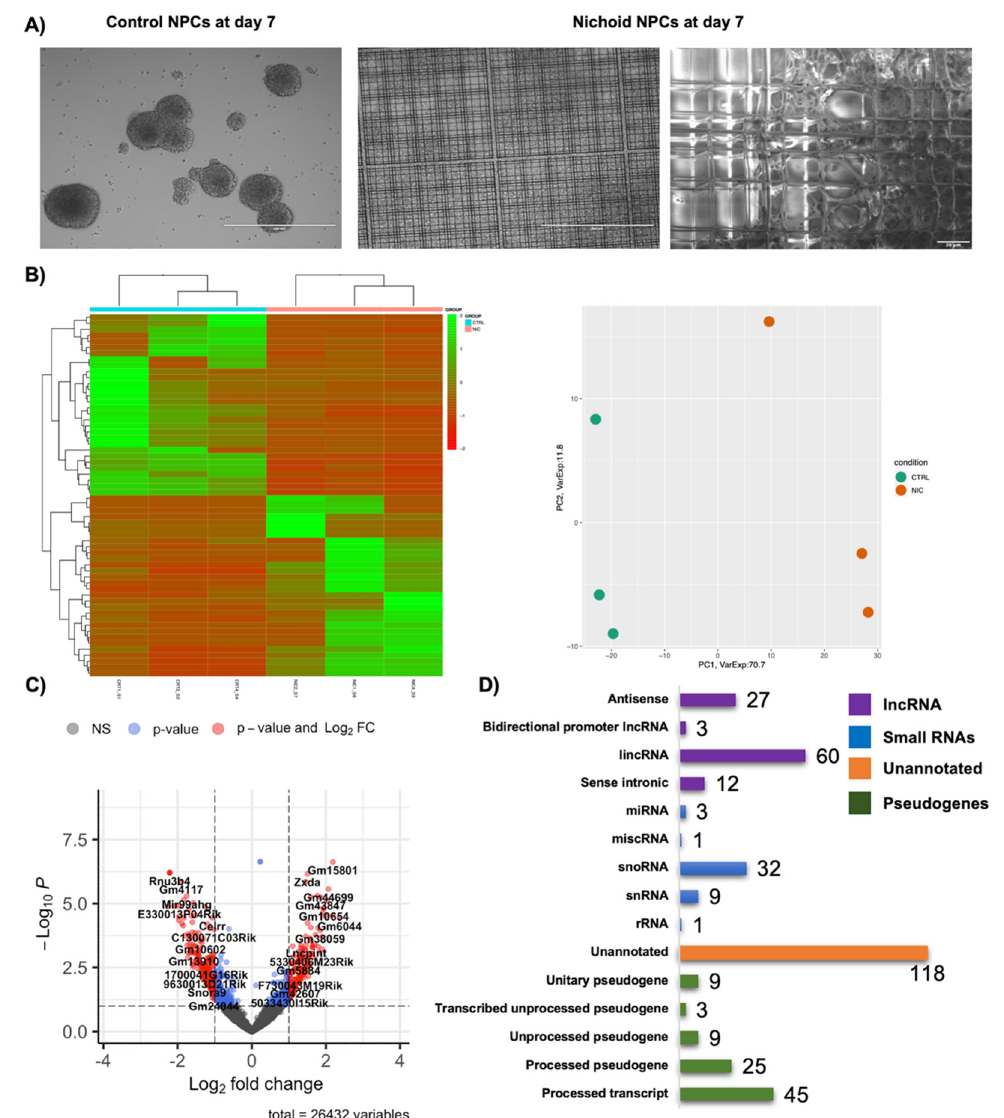
Figure 1. Change in morphology and transcription profiles in Neural Precursors Cells expanded inside the Nichoid. ( A ) On the left, in vivo direct light images (EVOS FL microscope, Euroclone) of NPCs neurospheres maintained in stem cells medium in standard floating conditions (Control NPCs) or grown, with the same medium, inside the Nichoid (Nichoid NPCs) for 7 days. Scale bar 400 µ m. Images are representative of observations obtained in more than 10 experiments. On the right, representative images of Nichoid-grown NPCs analyzed by Environmental Scanning Electron Microscope (ESEM). Scale bar 20 µ m. ( B ) For RNA-Seq, 3 samples for condition were analyzed. Specifically, three experiments were performed each including one sample of NPCs grown in standard floating conditions for 7 days and one sample of NPCs grown inside the Nichoid for 7 days. The graph shows the Heatmap and the PCA of non-coding differently expressed genes in NPCs grown on the Nichoid and in standard conditions. ( C ) Volcano plot showing only non-coding deregulated genes between NPCs grown on the Nichoid and in standard conditions. ( D ) Bar plot describing the classification of the non-coding deregulated genes found with RNA-Seq approach. Among the 357 non-coding deregulated genes, we identified 118 “unannotated genes”, 102 lncRNAs, 91 pseudogenes, and 46 small